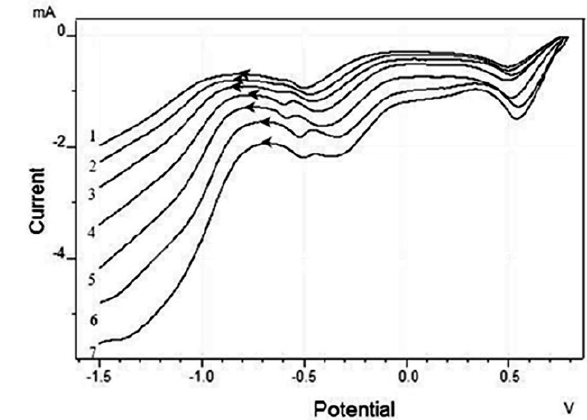
Fig. 1. Cyclic voltammetric curves of the electroreduction of iron (III) ions on a Pt electrode in a non-aqueous medium. The electro- lyte composition in (M): 0.1 М Fe(NO 3 ) 3 · 9H 2 O + CH 2 OH-CH 2 OH; at Т = 293 К, and Е V =0.02 V/s.